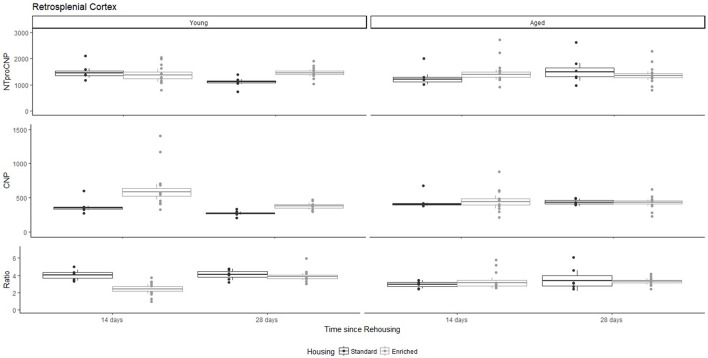
Concentration (femtomoles/g wet tissue) of NTproCNP (Top), CNP (Middle), and NTproCNP:CNP ratio (Bottom) within retrosplenial cortex. Summary data is 20% trimmed means (resulting in a reduction of n = 2 for all groups), standard error (box) and 95% confidence interval (whisker), overlaid by individual data points. For NTproCNP: Young-Standard-14-day > Young-Standard-28-day. For CNP: Young-Enriched-14-day > Aged overall > Other Young rats. For Ratio: Young-Enriched-14-day < Aged overall < Other Young rats.